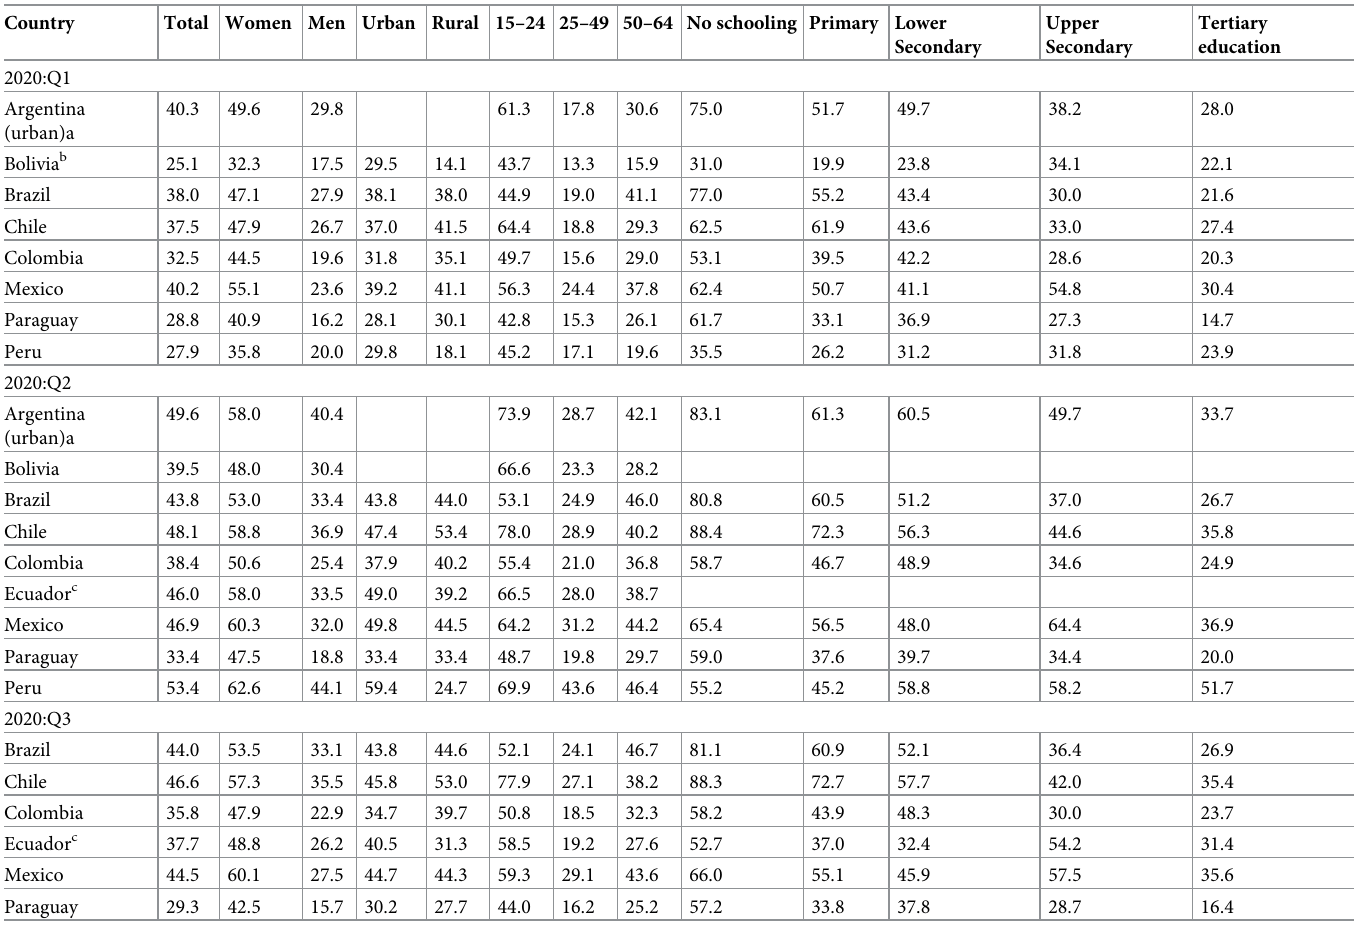
Table 5. Demographic profile of the inactive population as a percentage of the working-age population, 2020.